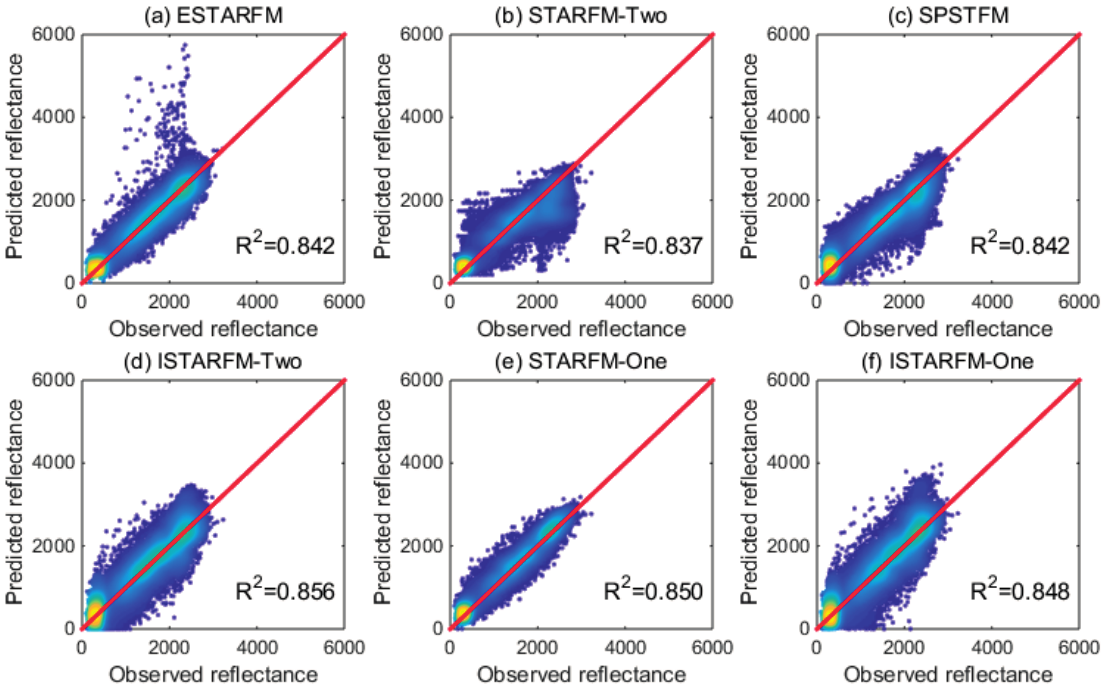
Figure 7. Comparison of the observed and predicted reflectance on 12 January 2002 for the red band (B3) from each blending model ( a – f ) using 1-to-1 fitting line at the CIA site. The scale factor of reflectance is 10,000, which was also used for the quantitative